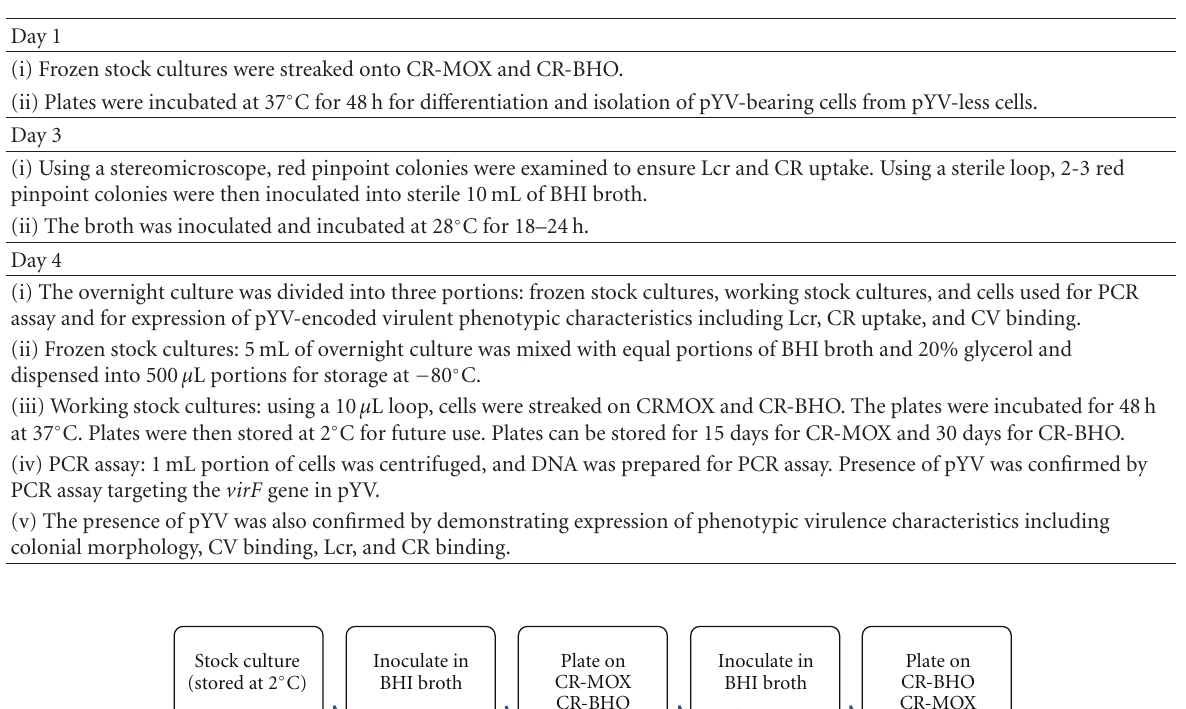
Table 3: Isolation and maintenance of pYV in Y. pestis [30] .